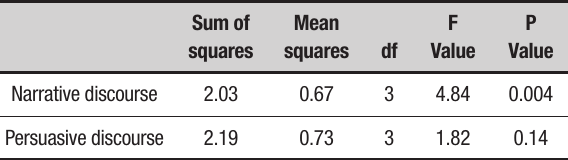
Table 4. Significance levels for macrostructure level (cohesion) in different age groups.